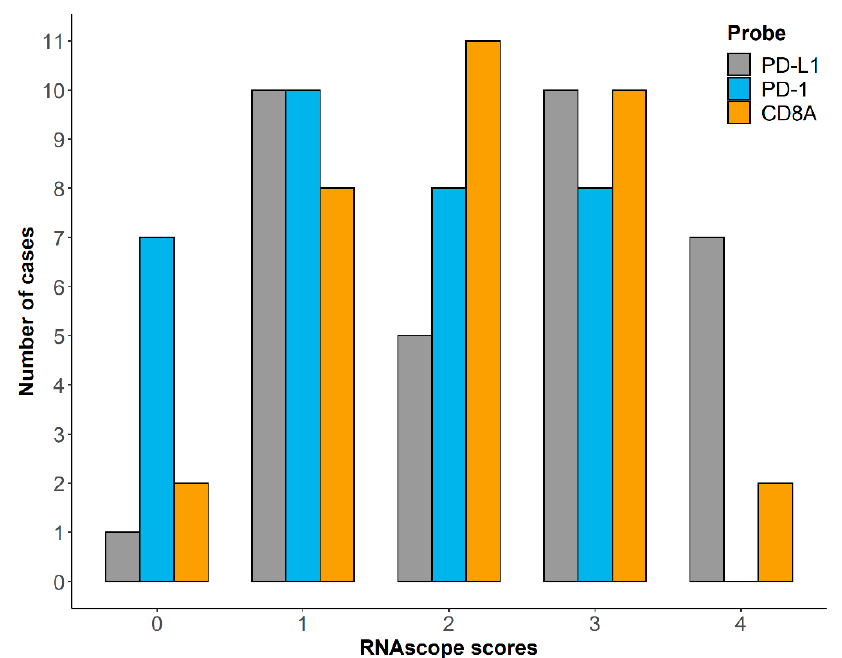
Figure 3. Distribution of RNAscope scores for PD-L1, PD-1 and CD8A among 33 cDLBCL samples.